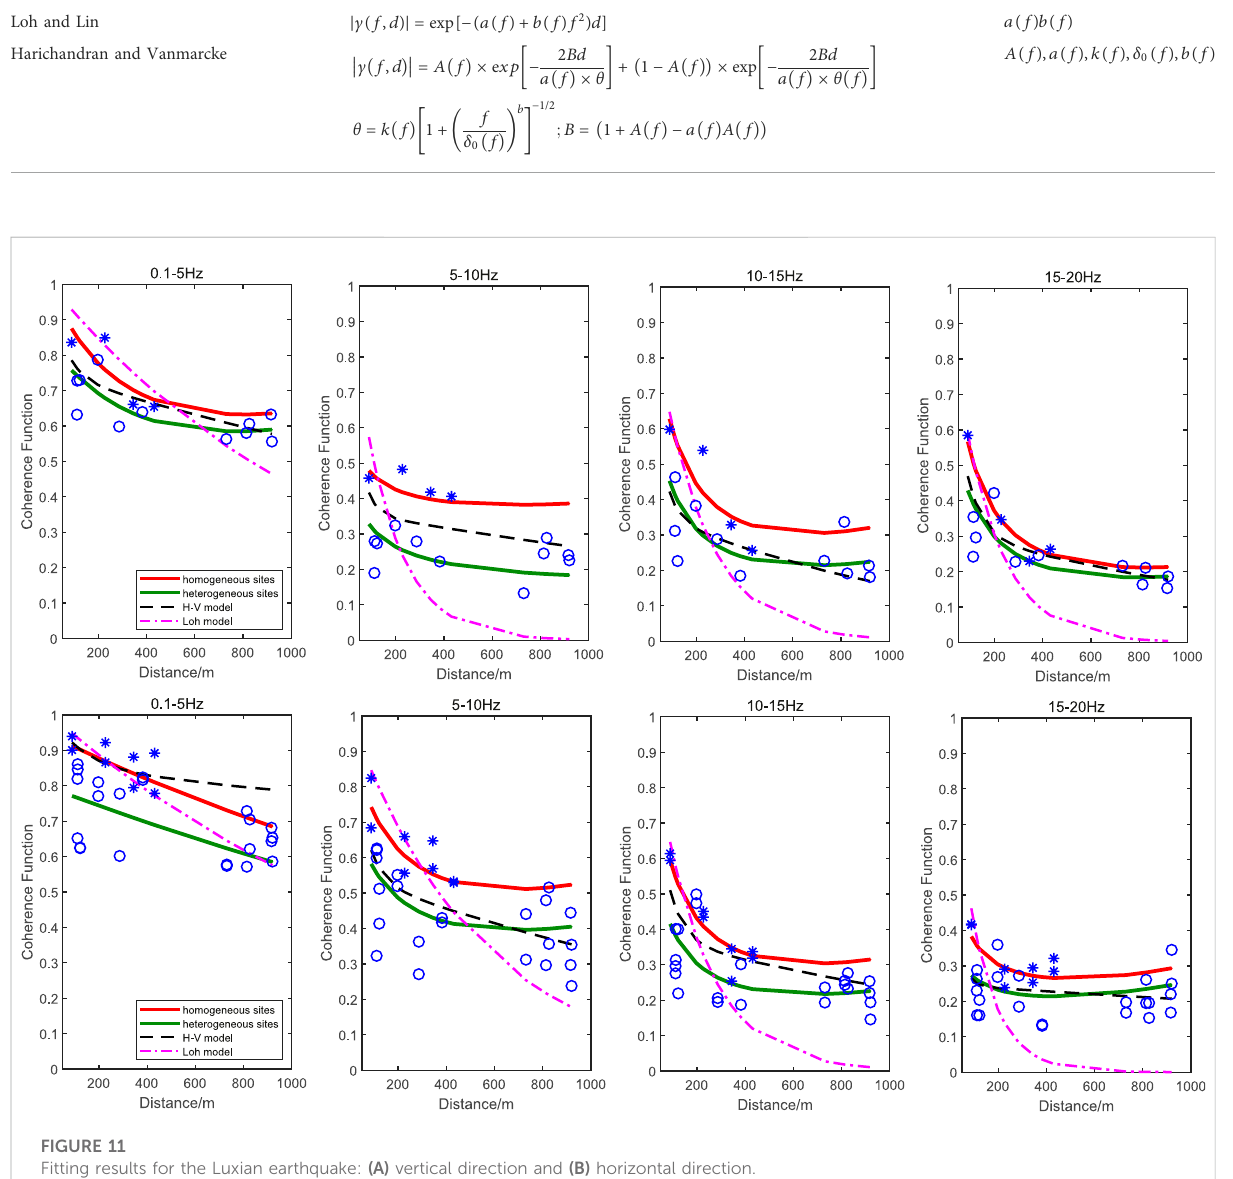
FIGURE 11 Fitting results for the Luxian earthquake: (A) vertical direction and (B) horizontal